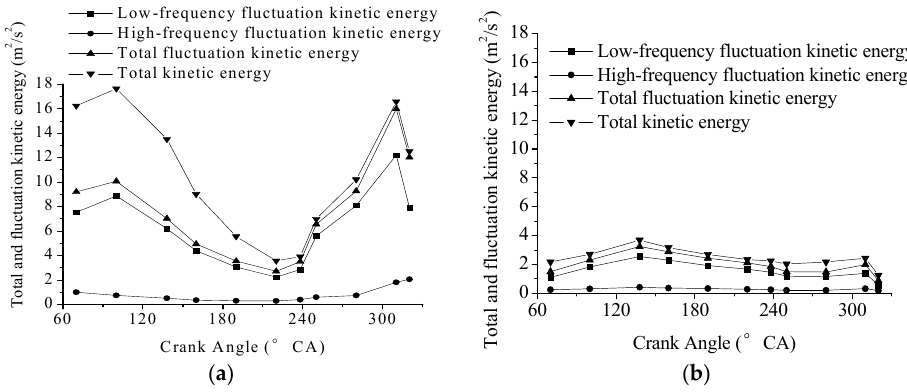
Figure 15. Averaged fluctuation kinetic energy of 100 cycles at Plane 1. ( a ) MVL = 1.7 mm; ( b ) MVL = 6.8 mm.